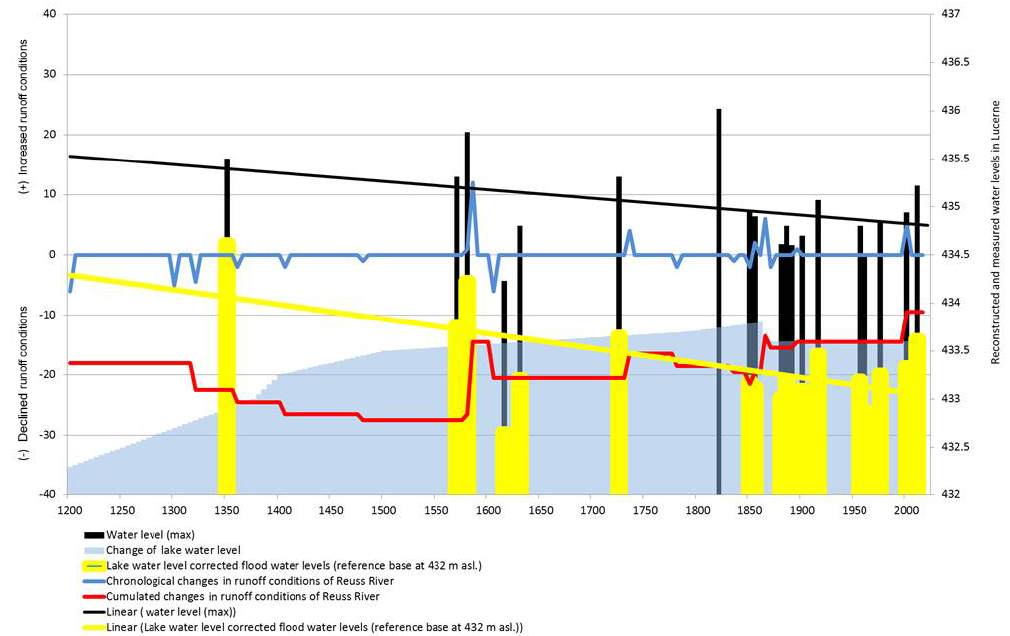
Figure 13. Significant increase in normal Lake Lucerne water levels versus a slight increase in Reuss River runoff conditions over the last 7